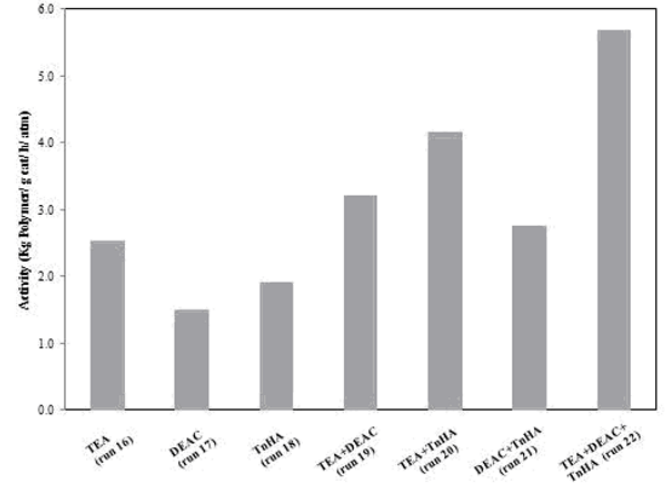
Figure 3. Effect of mixed activators on catalytic activity of MgCl catalyst for ethylene/1-hexene